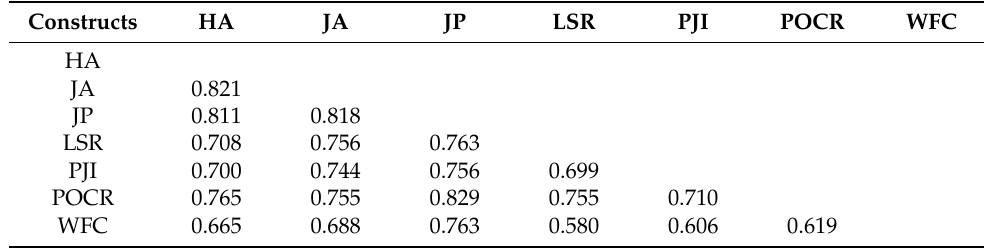
Table 4. Discriminant-validity analysis